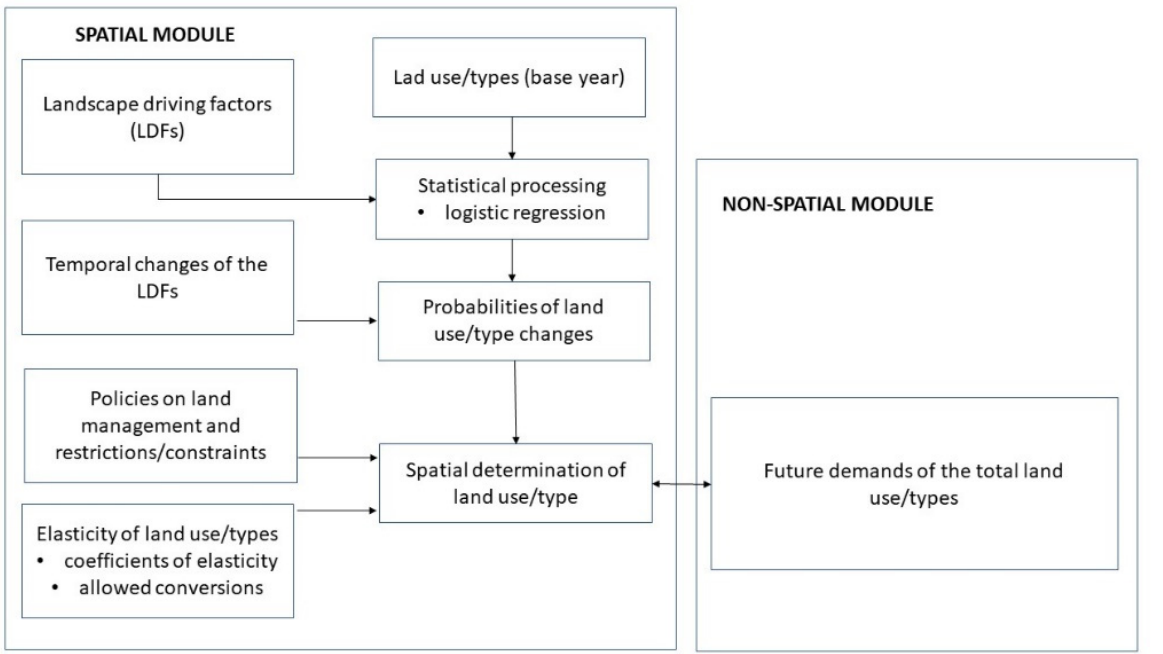
Figure 3. Flow chart representing the processes between spatial and non-spatial modules of CLUE- S.